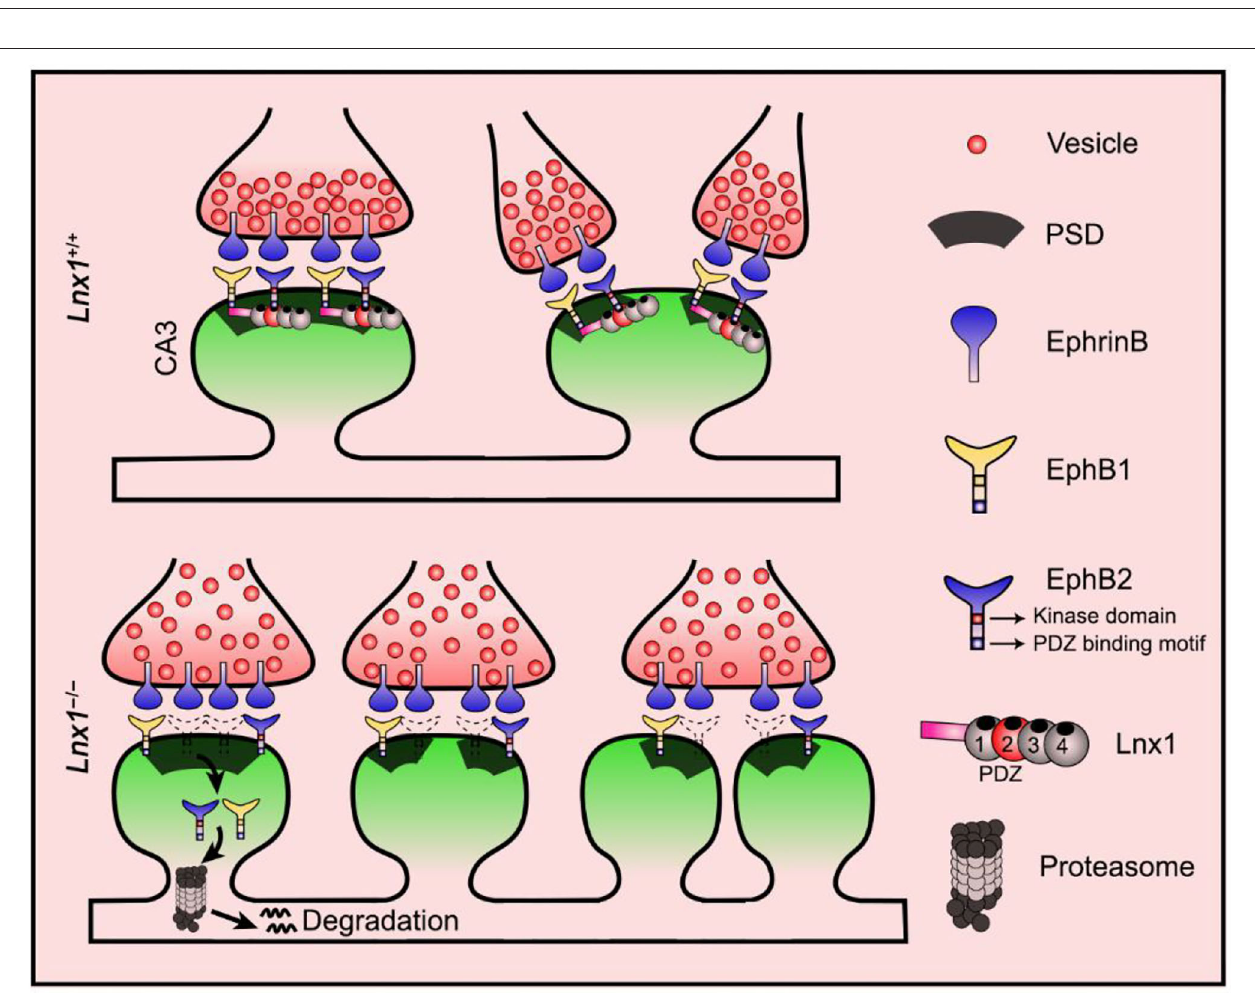
FIGURE 4 | (B) Statistical analysis of the internalized ratio of EphB2 receptors. (C) Quantification of internalized EphB2 and S20 co-localization (inter-EphB2 + S20 + ) / internalized EphB2 (Inter-EphB2 + ). n = 20 neurons from three biological replicates in WT, 20 neurons from three biological replicates in Lnx1 − / − and 21 neurons from three biological replicates in Lnx1 − / − ; EphB2 F620D / F620D . (D , E) Spine morphogenesis and the quantification of percentage distribution of spine head diameter and spine length in CA3 neurons from PW3 WT, EphB2 F620D / F620D , Lnx1 − / − , and Lnx1 − / − ; EphB2 F620D / F620D mice. Scale bars represent 3 µ m. (F) The increased spine density in Lnx1 − / − mice was restored to normal level in Lnx1 − / − ; EphB2 F620D / F620D mice. n = 39 neurons from 4 mice in WT, 27 neurons from 3 mice in EphB2 F620D / F620D , 43 neurons from 5 mice in the Lnx1 − / – group, and 36 neurons from 4 mice in Lnx1 − / – ; EphB2 F620D / F620D group. (G) The shorter PSD length in Lnx1 − / − mice was restored to normal level in Lnx1 − / − ; EphB2 F620D / F620D mice. n = 80 synapses in WT, 93 synapses in Lnx1 − / – , 72 synapses in EphB2 F620D / F620D , and 88